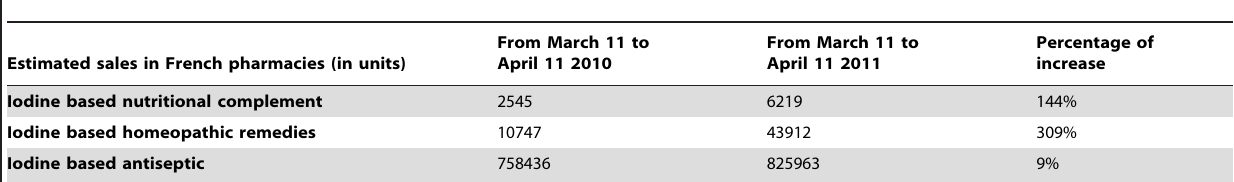
Table 1. Comparison of iodine based products in one month in 2010 and the same month in 2011 after the beginning of the Fukushima